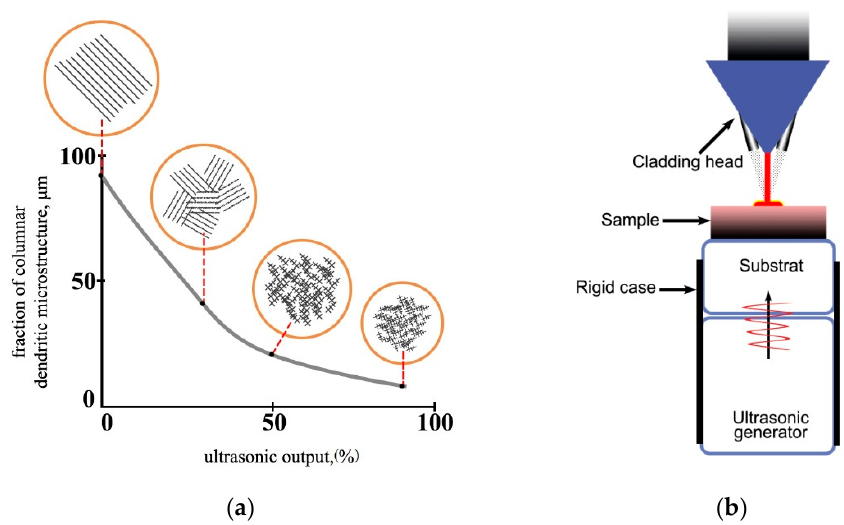
Figure 1. ( a ) Fraction of the columnar dendritic microstructure in the weld metal as a function of the US vibration (Adapted with permission from ref. [19]. Copyright 2007 WILEY). ( b ) Schematic of US-assisted L-DED.